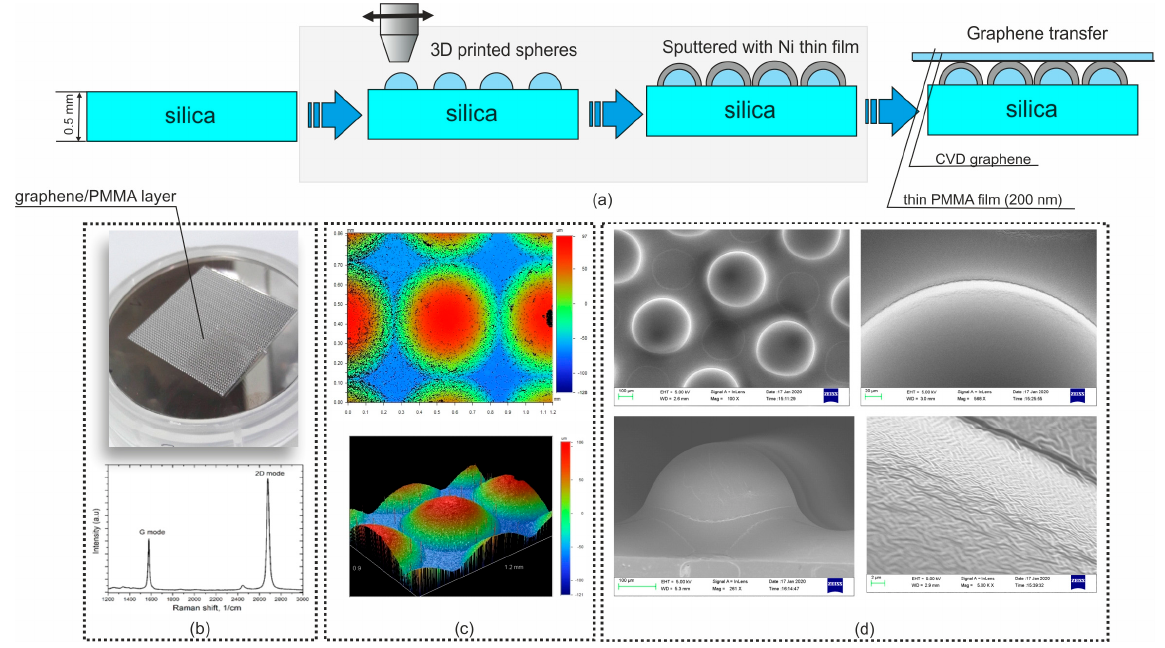
Figure 3. ( a ) Schematic presentation of the graphene enhanced structure fabrication using high ‐ resolution 3D printing. ( b ) Photographic image of the fabricated structure and Raman spectrum of CVD graphene transferred on Si/SiO 2 (300 nm) substrate for characterization. ( c ) Surface profile of the fabricated structure. ( d ) SEM images of 3D printed polymer hemispheres covered with Ni at different magnifications.